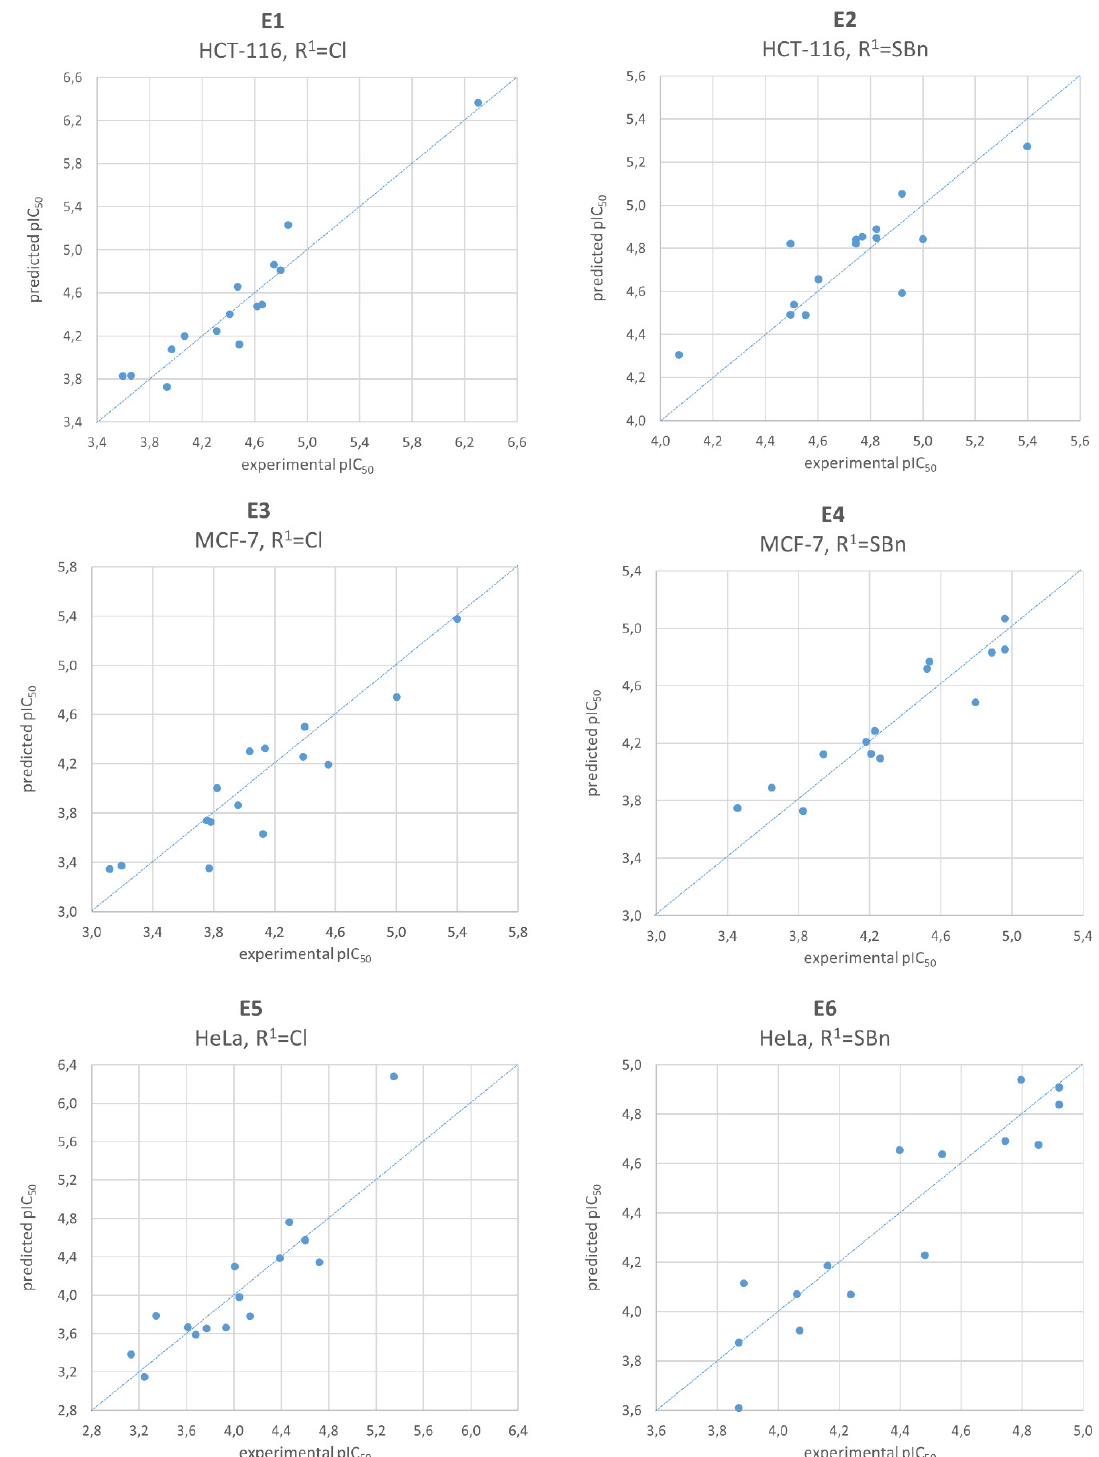
Figure 5. Plots of experimental vs predicted in 5-fold cross validation values of IC 50 for equations E1 - E6